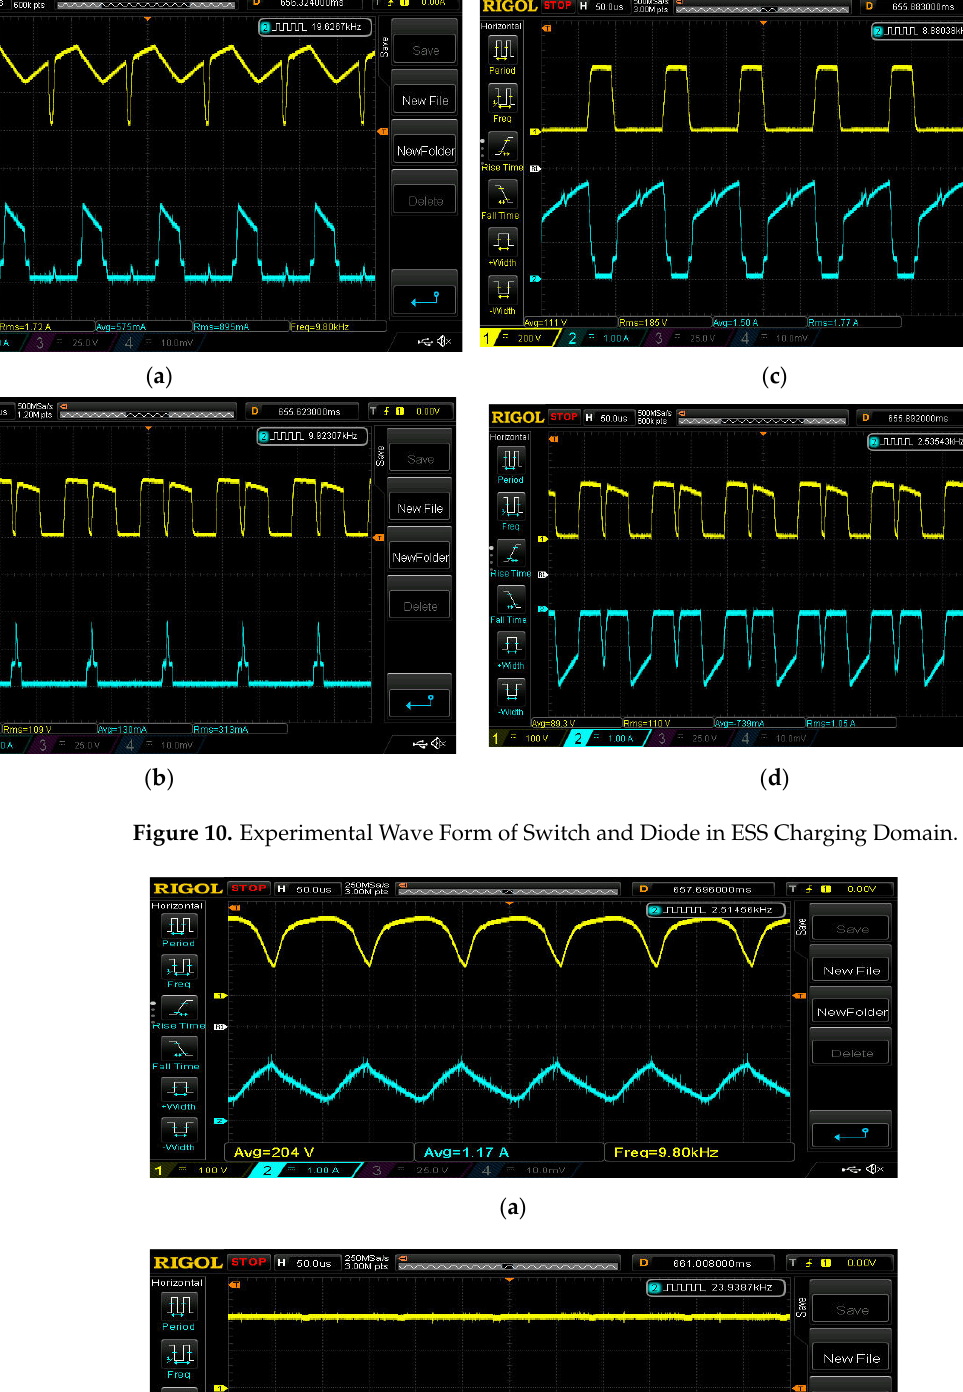
( d ) Figure 12. Experimental Wave Form of Switch and Diode in ESS Least Domain.